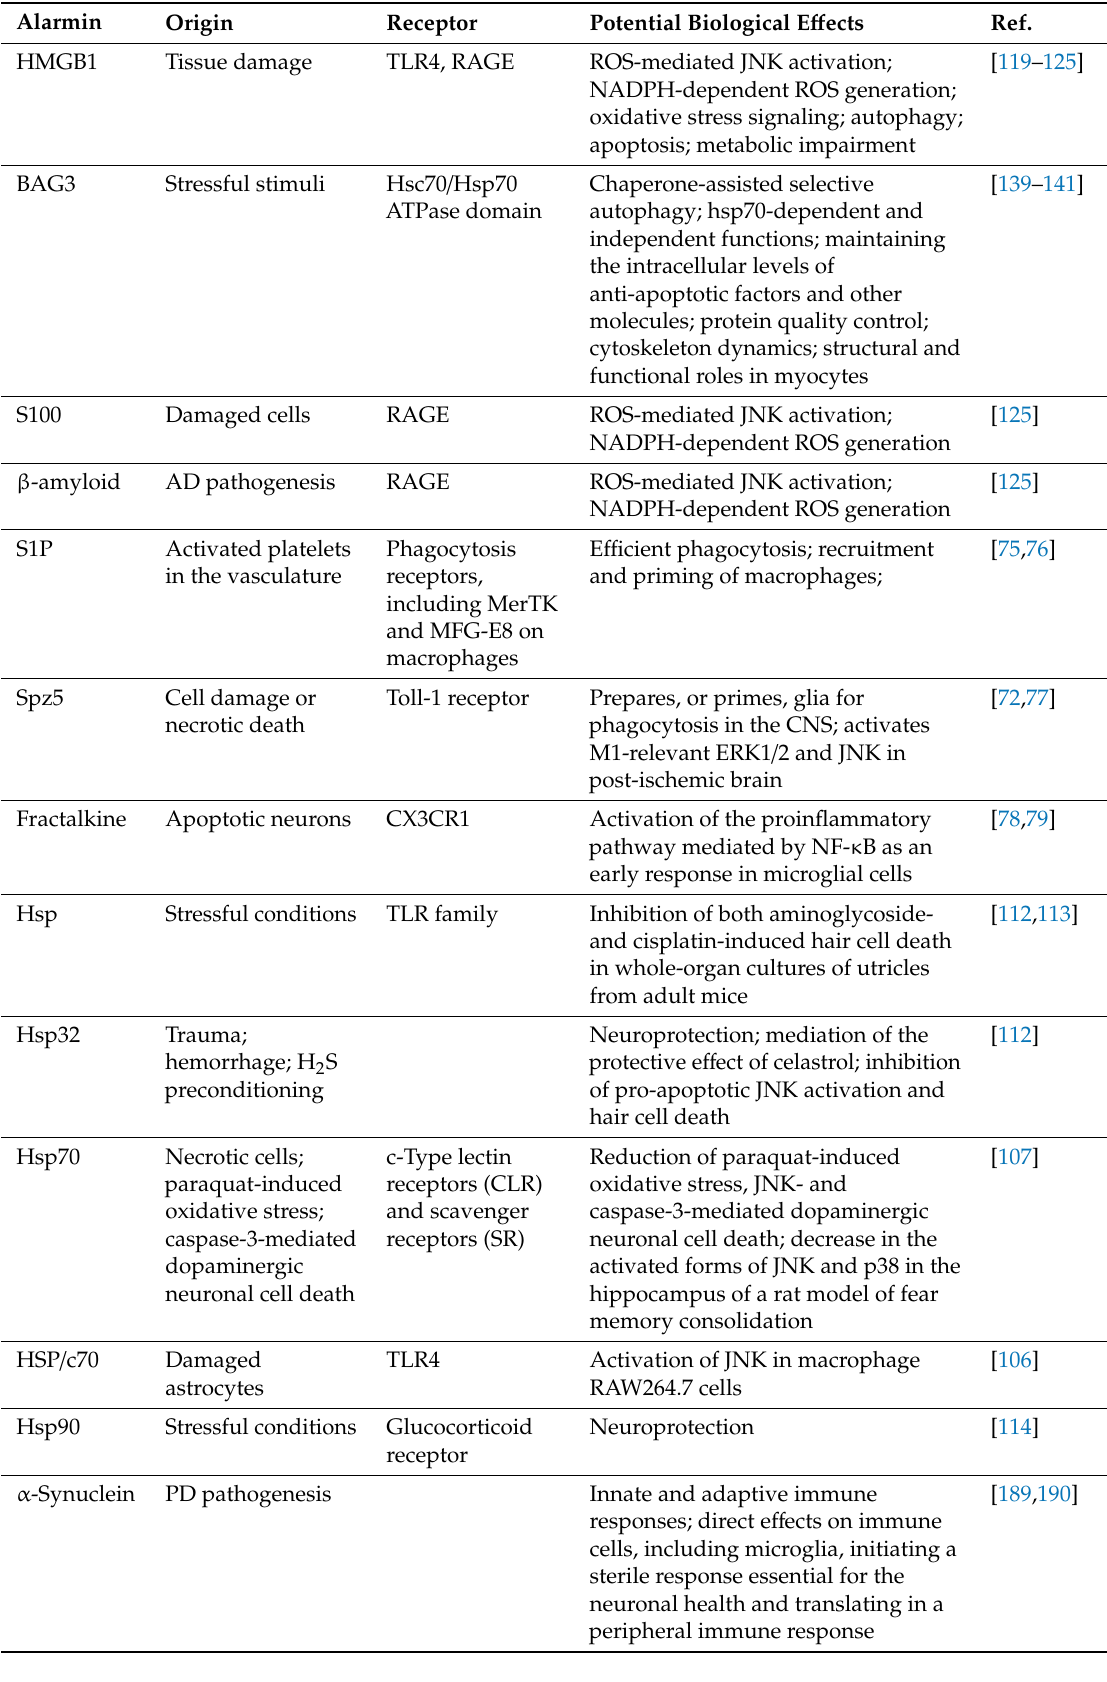
Table 1. The origins, receptors and potential biological e ff ects of alarmins in neuroinflammation